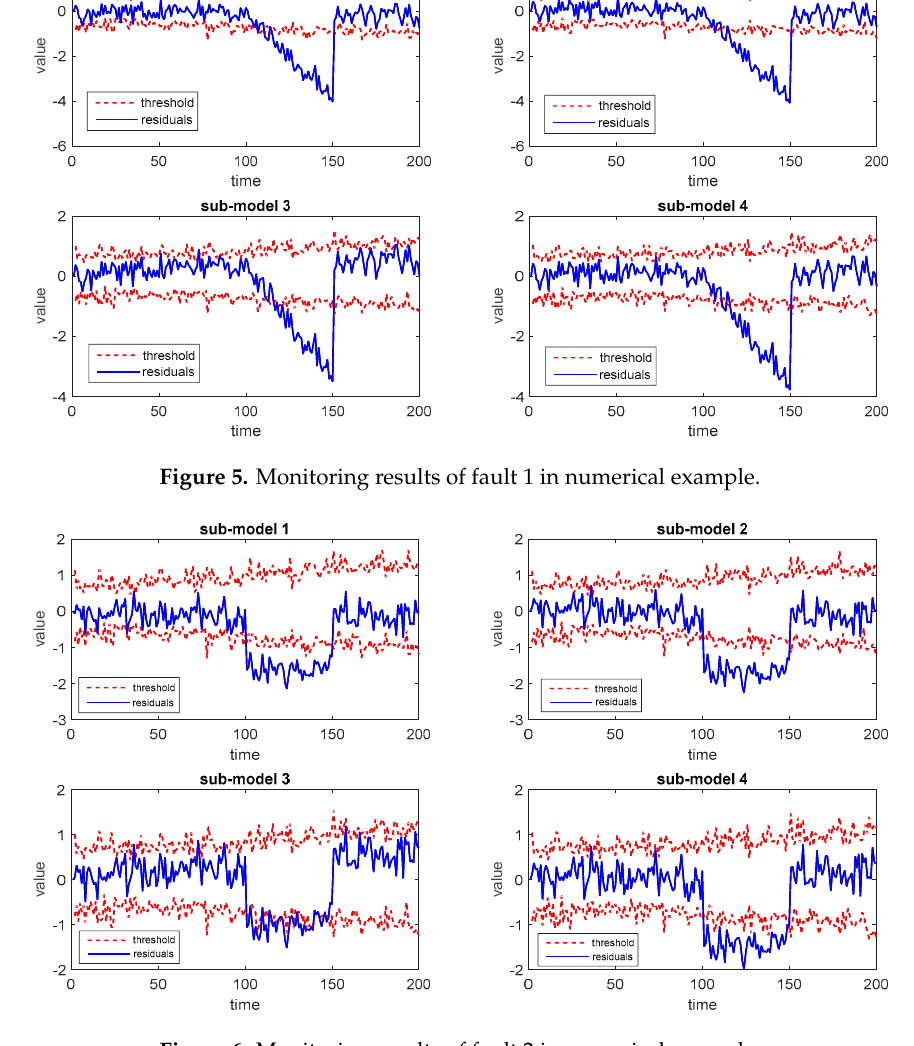
Figure 6. Monitoring results of fault 2 in numerical example. Table 3. FAR and FDR under di ff erent ensemble strategies in numerical